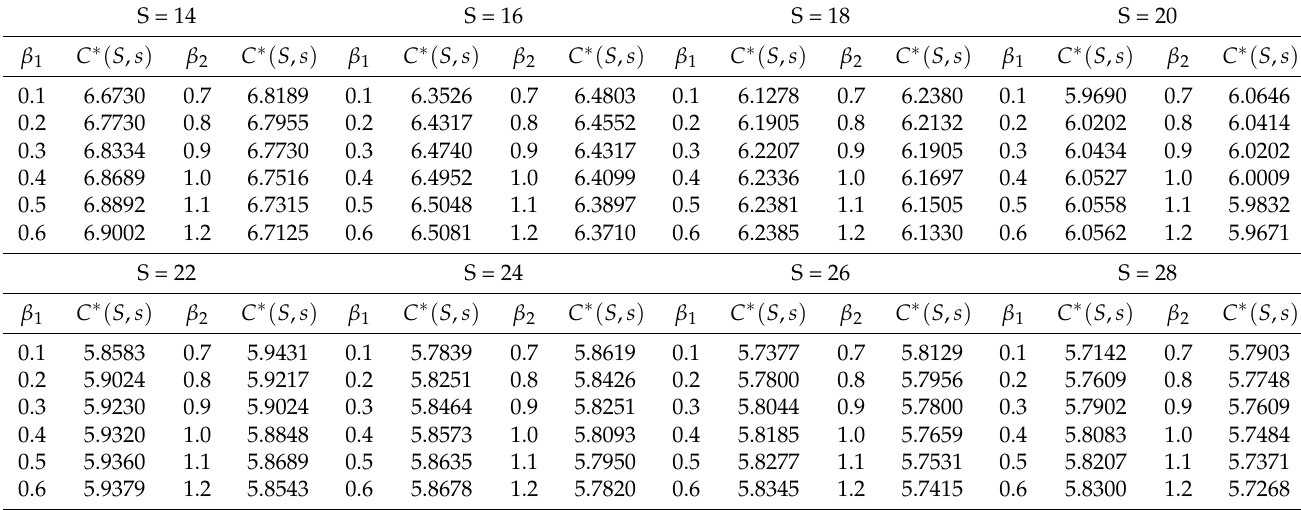
Table 2. The optimal cost value for different values of lead